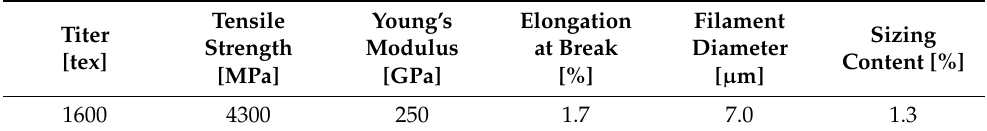
Table 1. Selected properties of the used carbon rovings Tenax™-E STS40 E23 24K according to the manufacturer [32].